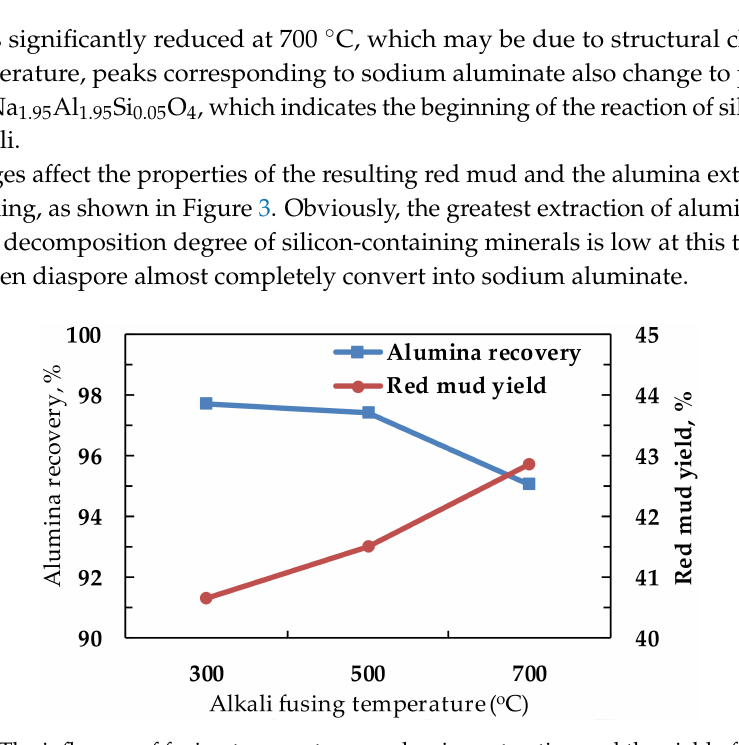
Table 2. The chemical compositions of red muds, wt. %.